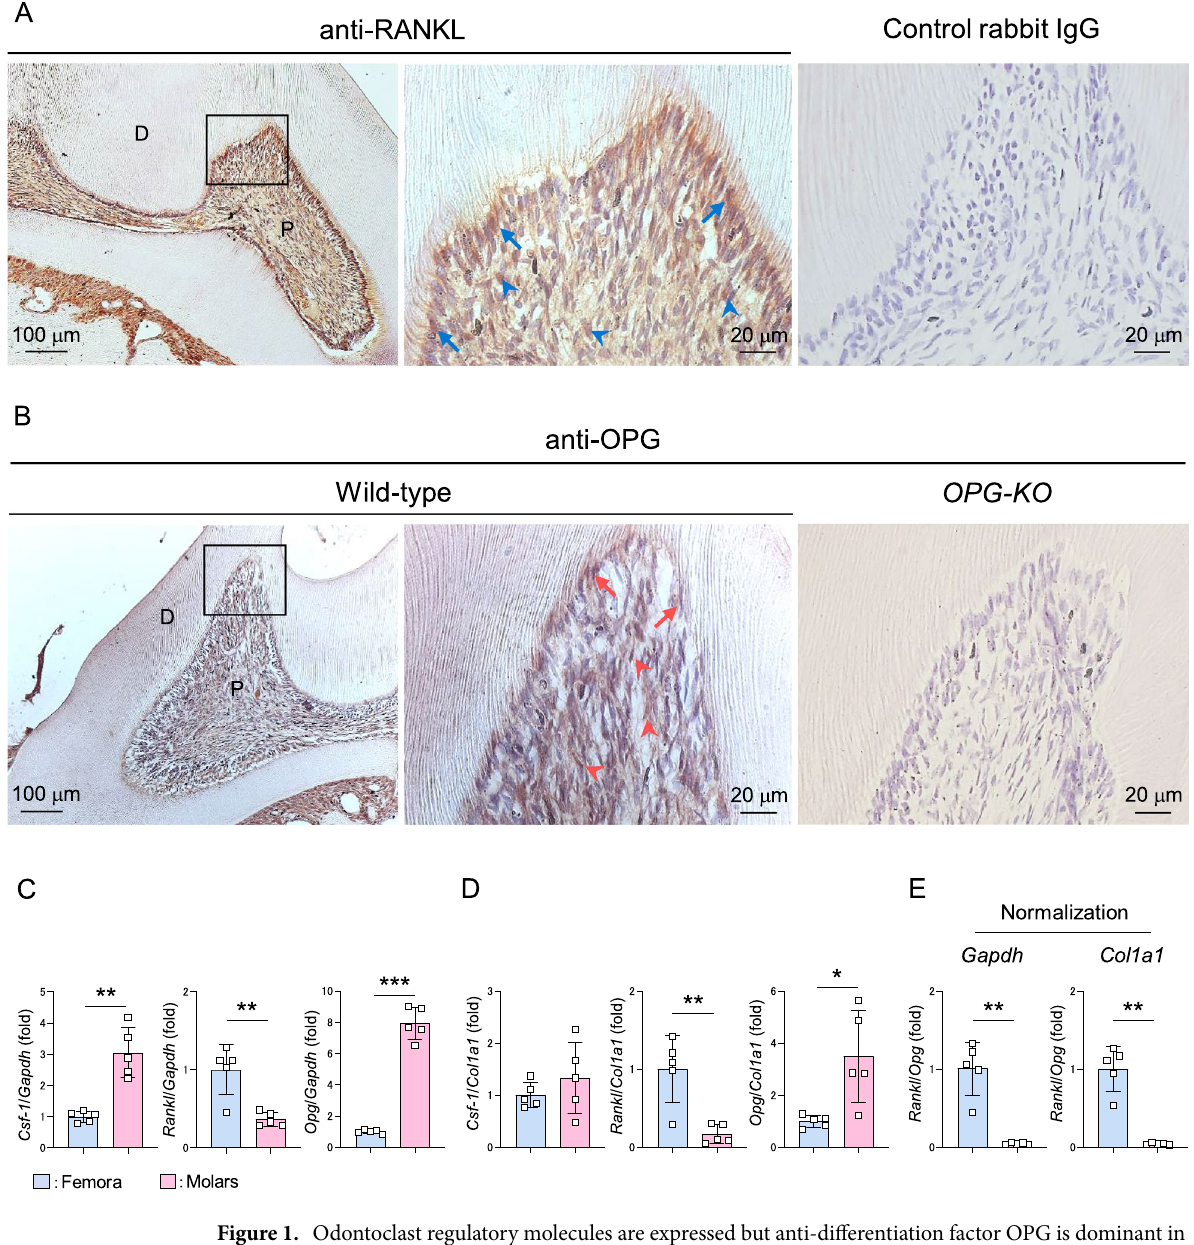
mice (Fig. 3A, asterisks), and TRAP + odontoclast-like cells were induced in the dental pulp tissue; though, the odontoclasts were not observed in the undamaged dental tissue (Fig. 3B, upper panels and Fig. 3C). Further- more, a significantly higher number of TRAP + odontoblast-like cells were observed as mono- or multi-nucleated cells in the damage-induced pulp tissue of OPG-KO mice (Fig. 3B, lower panels, mono (black arrows)- or multi (black arrowheads)-nucleated TRAP + odontoclast-like cells), compared to wild-type mice (Fig. 3B, upper pan- els, black arrows: mono-nucleated TRAP + odontoclast-like cells; quantification shown in Fig. 3C). Although, damage-induced TRAP + odontoclast-like cells were not observed as dentin-resorbing cells, the cells were posi-